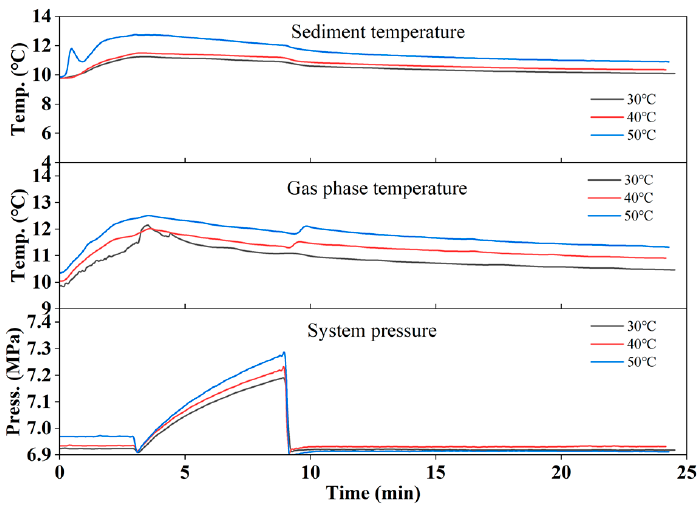
Figure 5. Temperature and pressure changes under different injection temperatures in the sediments at 9 °C and 6.9 MPa with 30% hydrate saturation.